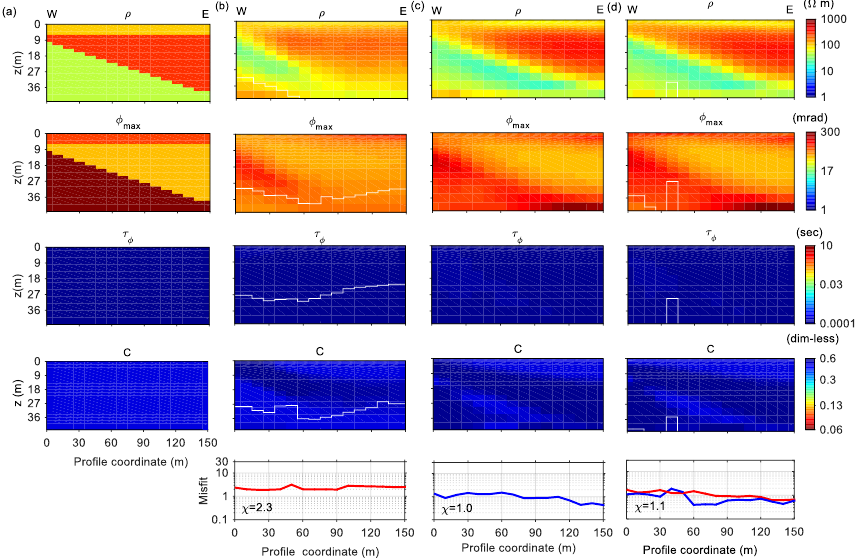
Figure 9. Comparison between the true model ( a ) and estimated MPA parameters of the strong chargeable medium by x -data only ( b ); z -data only ( c ); and x and z data ( d ). The meanings of the curves and the area are the same as in Figure